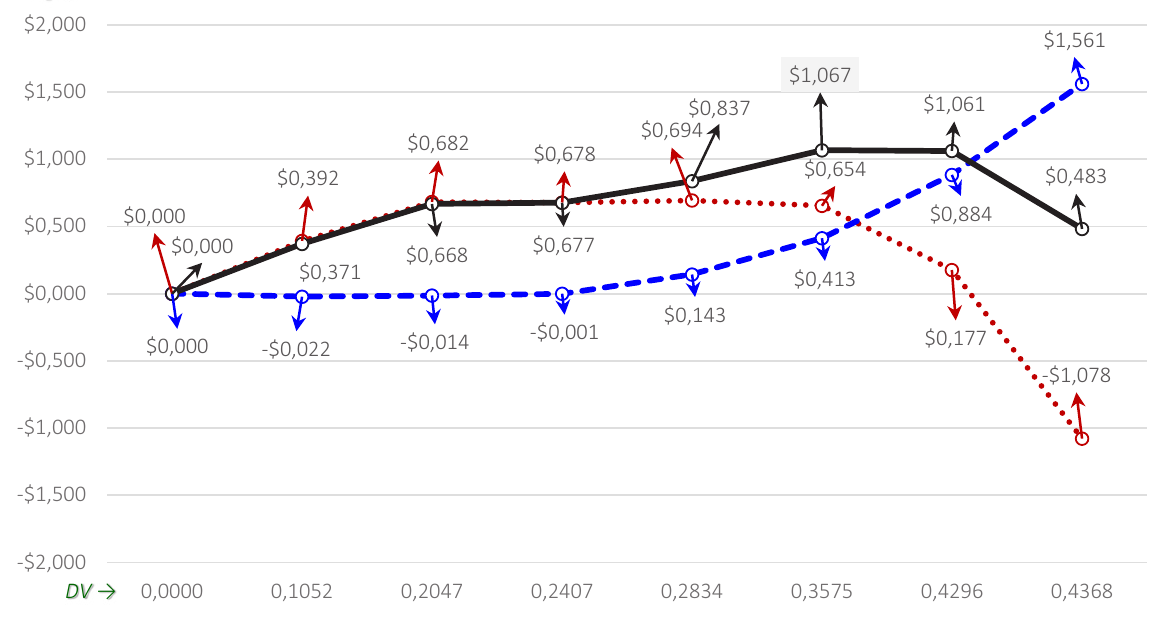
) Results for Large Growth Test with Target Credit Rating of A3. G Figure 1. Gain to Leverage ( G L its two components in millions of dollars are plotted against feasible DV outcomes. The solid line is G . The dotted line is the 1 st component of G . The dashed line is the second component of G L L